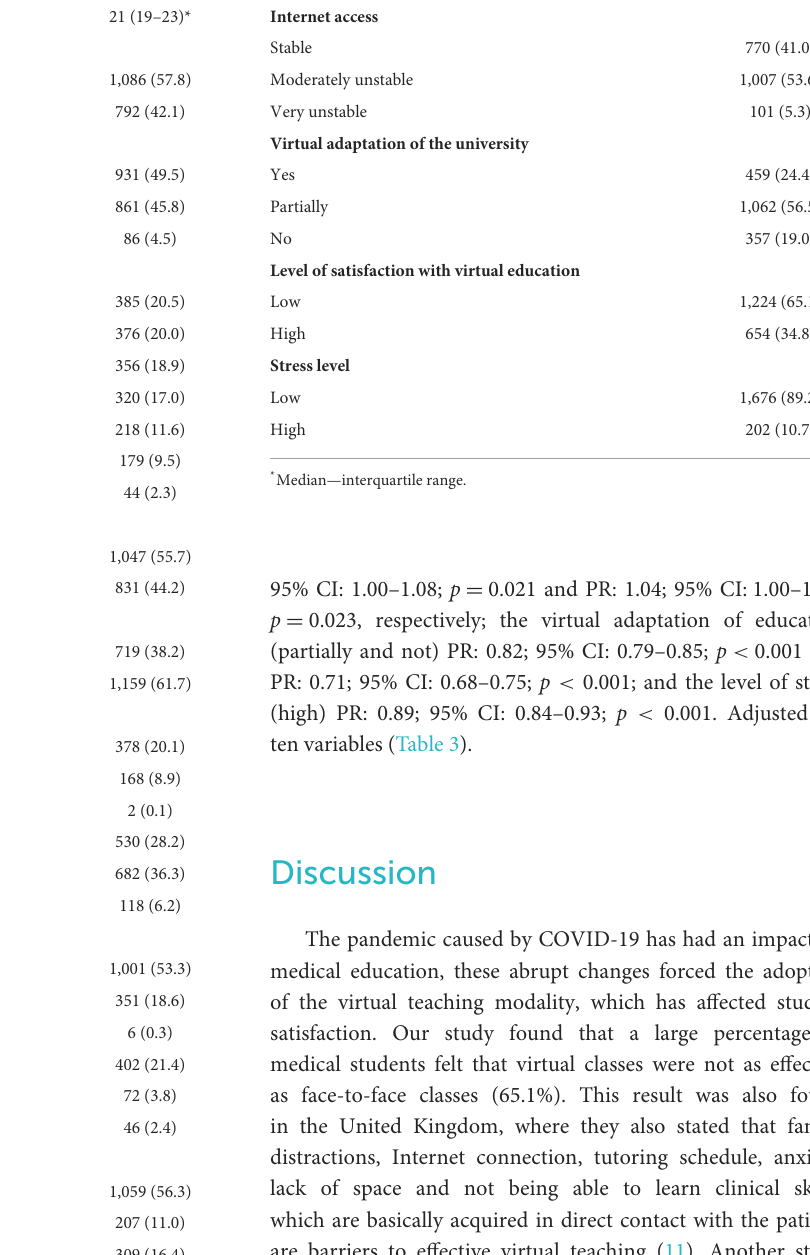
TABLE 1 Characteristics of the study population ( n = 1,878).